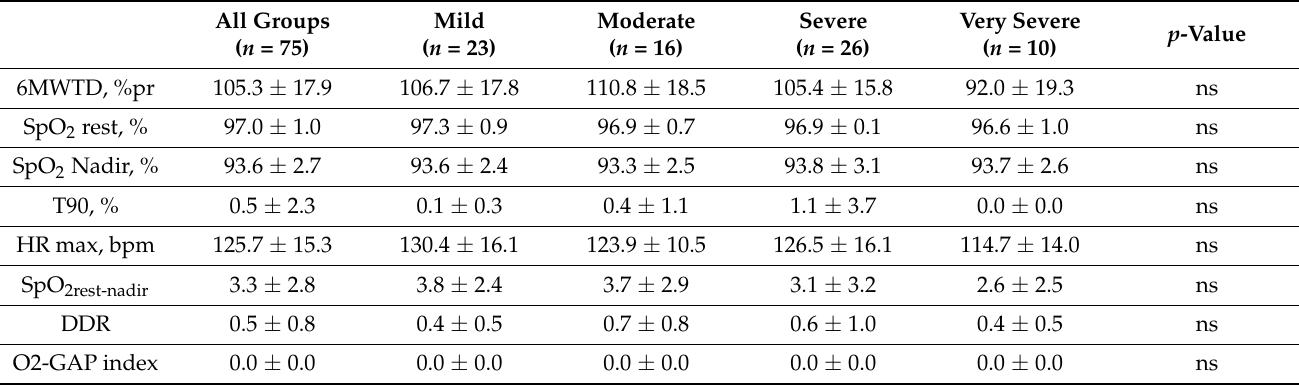
Table 4. Six-minute walk test’s parameters.